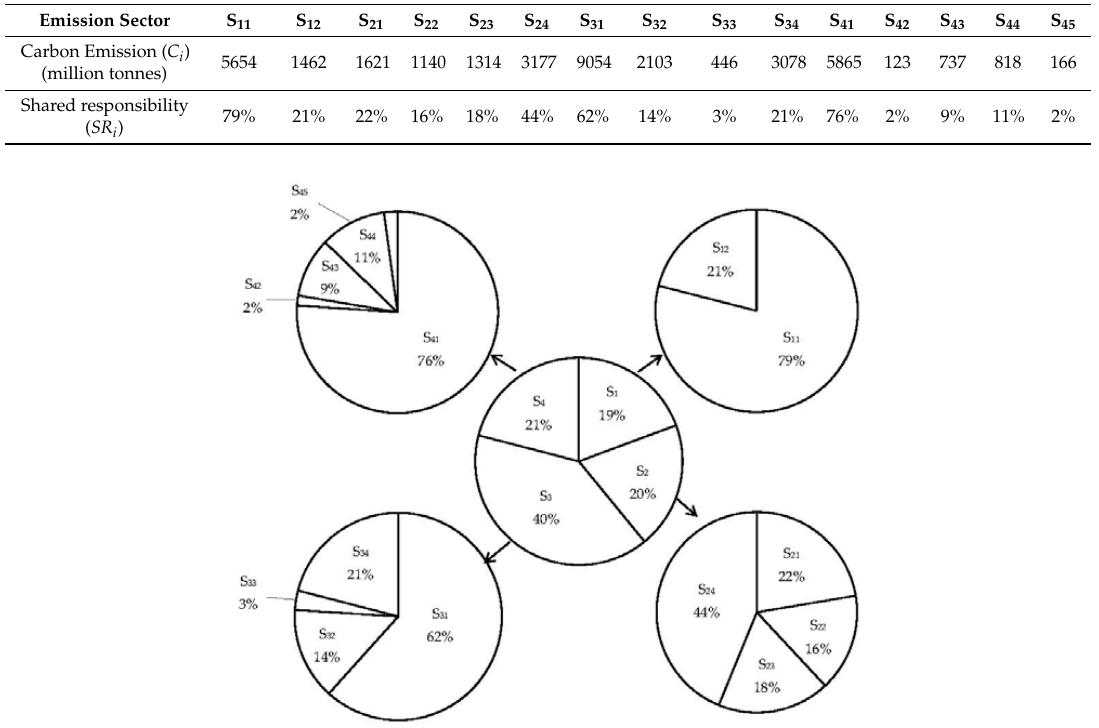
Figure 4. Shared responsibility between various emission sectors.